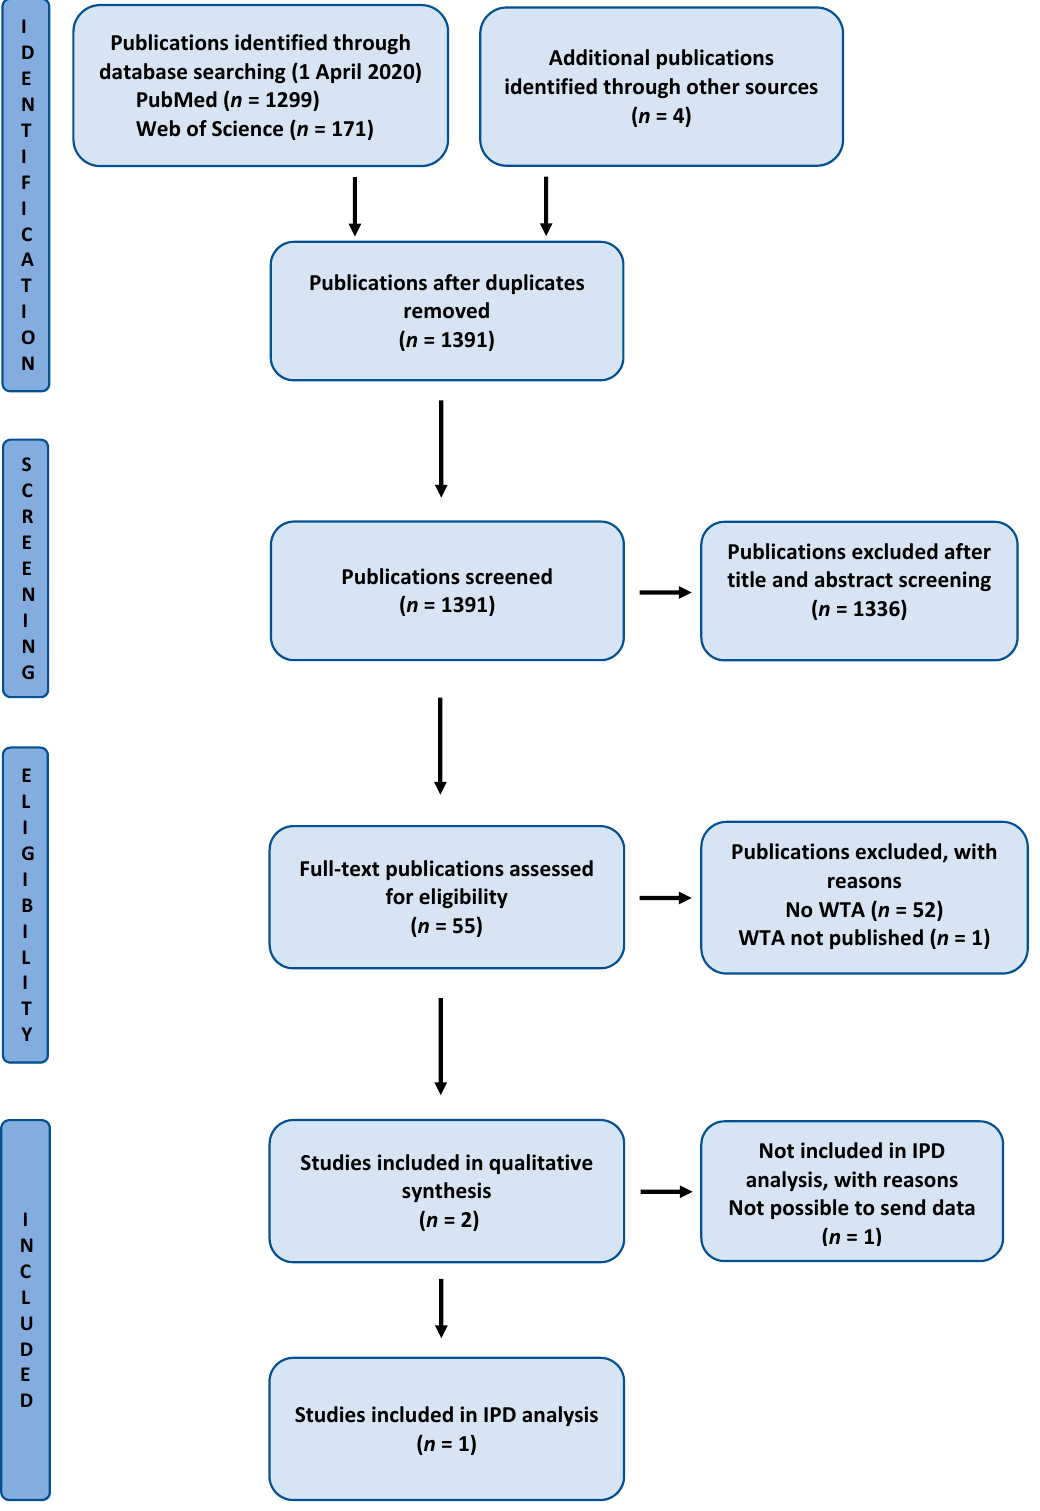
Figure 1. PRISMA (Preferred Reporting Items for Systematic Reviews and Meta-Analyses) flow diagram. IPD, individual participant data; WTA, willingness to